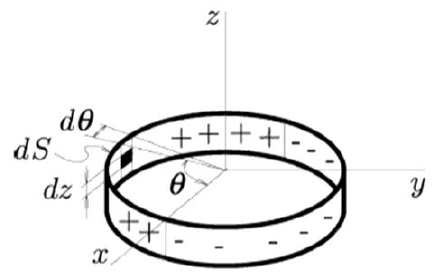
Figure 5. Dipolar representation of a cylindrical hole defect.